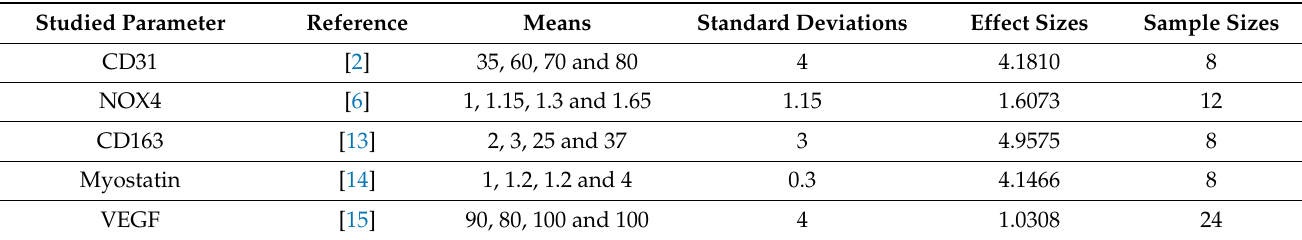
Table 1. Sample size